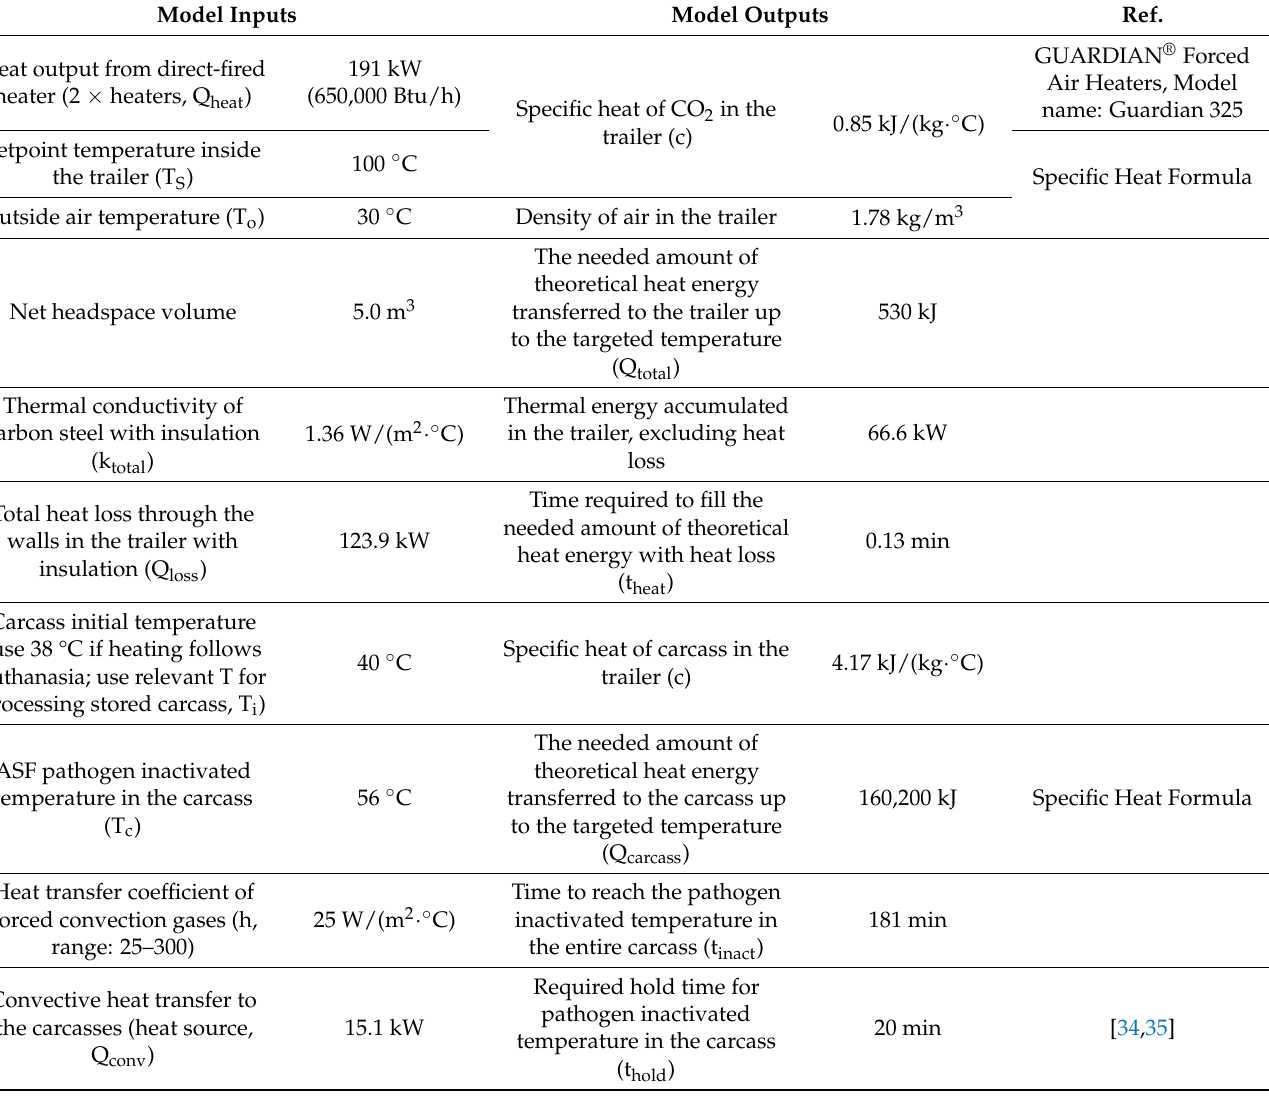
Table 5. Example of required heat treatment time needed to inactivate PRRSV in a batch of pig carcass. Model Inputs Model Outputs